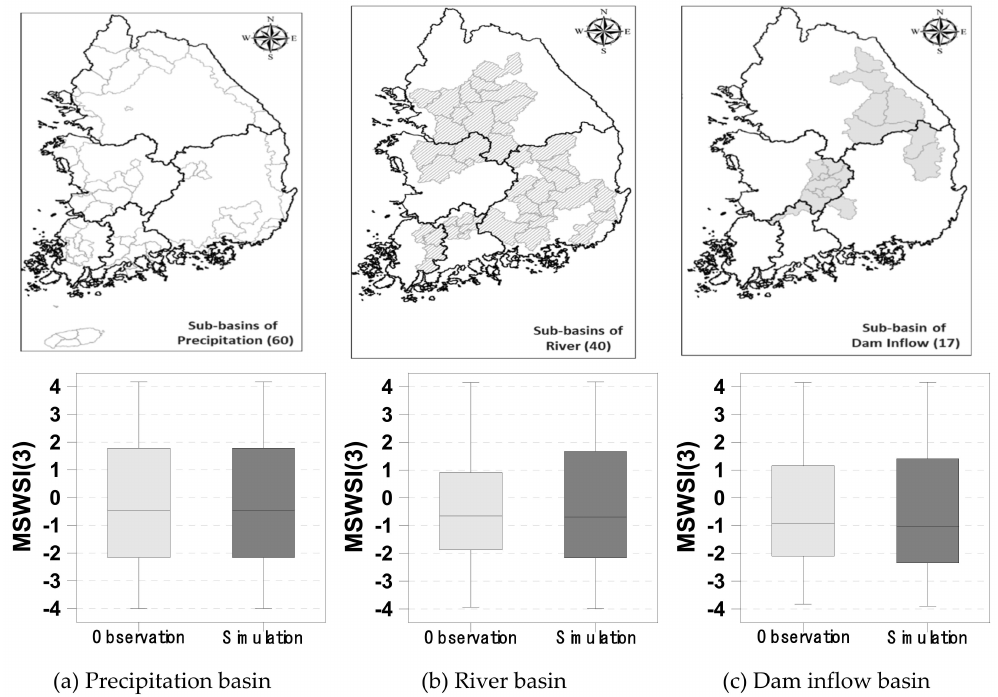
Figure 6. Classification of subbasin types (upper) and box–whisker plots of MSWSI(3) for each basin type (lower). The gray bar and black bar indicates observation − and simulation −